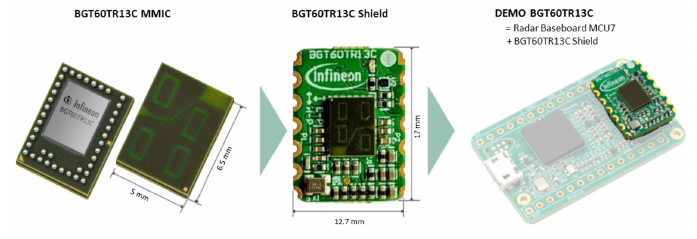
Figure 13. BGT60TR13C radar from Infineon Technologies AG. Source: [47]. It has four integrated antennas, which are depicted as light green rectangles in Figure 13. One antenna is used for transmitting (upper left antenna in Figure 13) and three for receiving [48]. The first receiver antenna is the upper right, the second the lower left, and the third the one at the bottom right patch in Figure 13. The receiver antennas were placed in an L-shape (as visualized in Figure 13) such that both vertical and horizontal angles of arrival could be